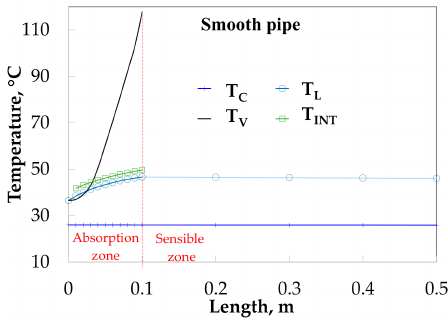
Figure 7. Temperature profiles along bubble absorber length without HM in the inside tube.